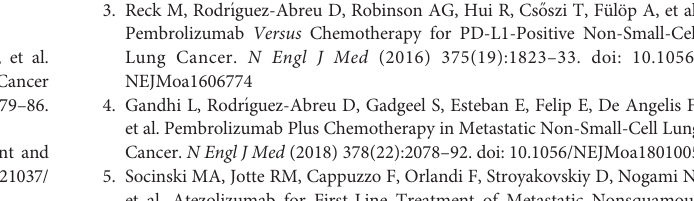
Supplementary Figure 1 | Differences between pre-treatment NLR values and NLR values (A) at disease progression ( p -value from Wilcoxon signed-rank test: 0.027) and (B) at response ( p -value from Wilcoxon signed-rank test: 0.030).